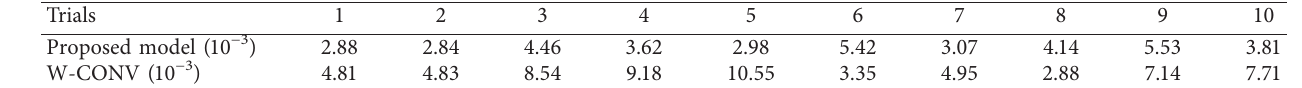
Table 6: Comparison of two models using RMSE of 10 trials.